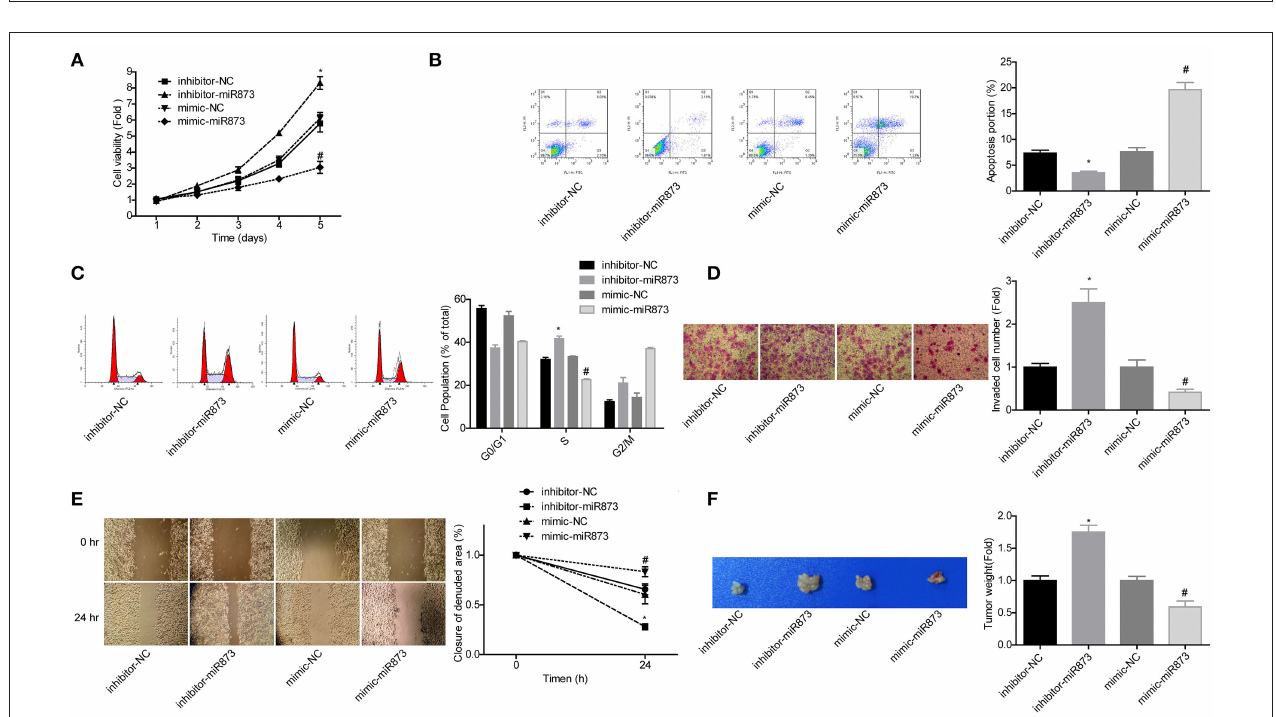
FIGURE 5 | MiR-873 played critical roles in the progression of NB. (A) Proliferation of SK-N-SH cells was detected by CCK-8 assay. (B) Apoptosis of SK-N-SH cells was detected by flow cytometry. (C) Cell cycle of SK-N-SH cells was assessed by flow cytometry. (D) Cell invasion and (E) migration were determined by transwell experiment and wound healing assay in SK-N-SH cells. (F) Xenograft model was established to detect the tumorigenesis of SK-N-SH cells in vivo (* P < 0.05, vs. inhibitor-NC group, # P < 0.05, vs. mimic-NC group).